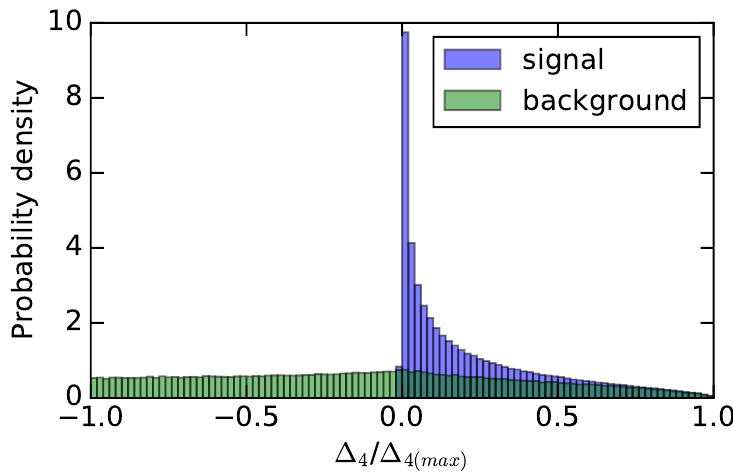
Figure 3 . The (cid:1) 4 histograms for signal (blue) and (uniformly distributed) background (green). The distributions are normalized by the maximum (cid:1) 4 value for the chosen mass spectrum, ( m X ; m X ; m X ; m (cid:31) ) = (390 ; 360 ; 330 ; 300) GeV. The feature in the background distribution near 1 2 3 (cid:1) 4 = 0 is caused by the volume between constant (cid:1) 4 surfaces becoming